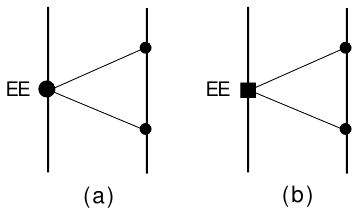
Figure 1 . The leading Feynman graphs of two-graviton exchange due to quadratic-in-curvature operators entering first at the 5 PN order. (a) The tidal interaction in the point-mass sector. (b) The new interaction in the present quadratic-in-spin sectors, due to the new quadratic-in-curvature coupling to